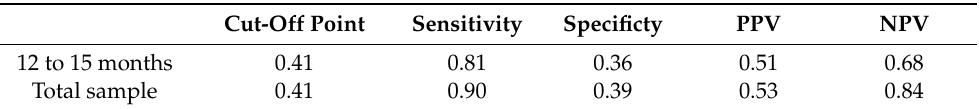
Table 4. Cut-off points and validity data of the DBI scale with cognitive impairment in 12 to 15 months’ evaluation and total sample. Cut-Off Point Sensitivity Specificty